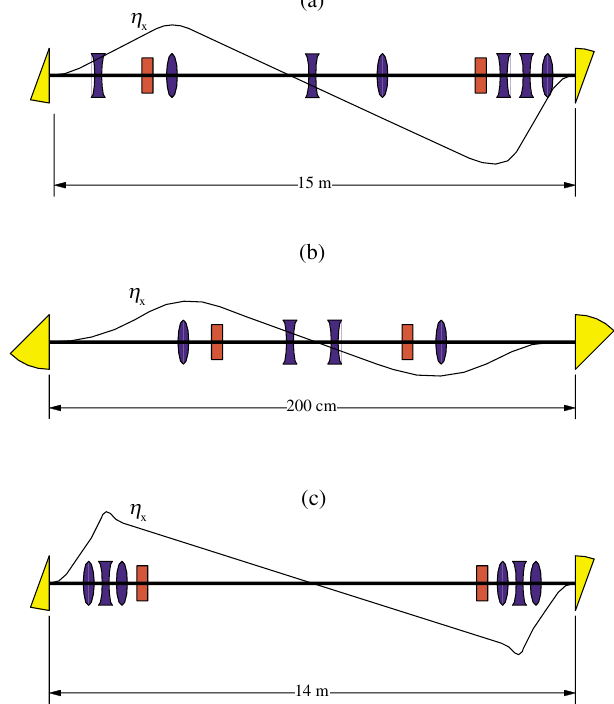
FIG. 1. (Color) Cartoon drawings of the dispersionless trans- lating sections at (a) ATF-VISA, (b) UCLA-Neptune, and (c) ORION-SLAC. Each drawing is scaled to fit the figure. Wedges, blue lenses, and red rectangles represent dipoles, quad- rupoles, and sextupoles, respectively. In each drawing an ap- proximate representation of the horizontal dispersion function (cid:24) is x